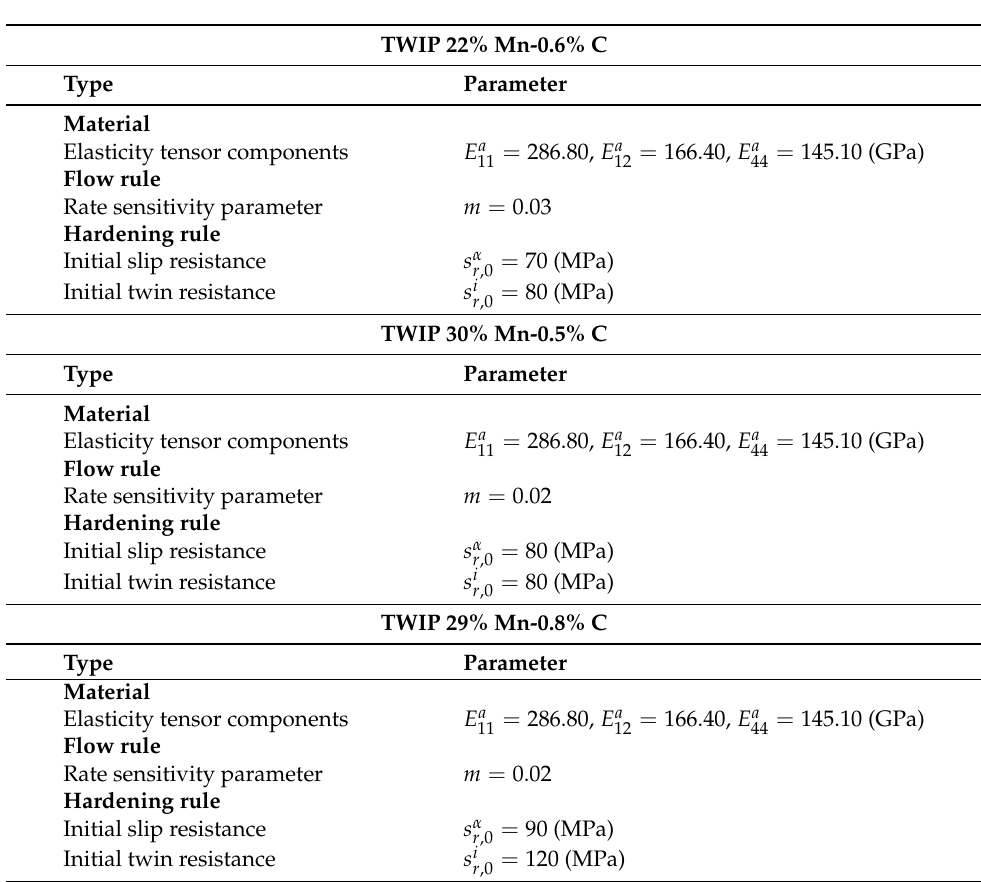
Table 3. Specific modeling parameters of TWIP 22% Mn-0.6% C, TWIP 30% Mn-0.5% C, and TWIP 29% Mn-0.8% C